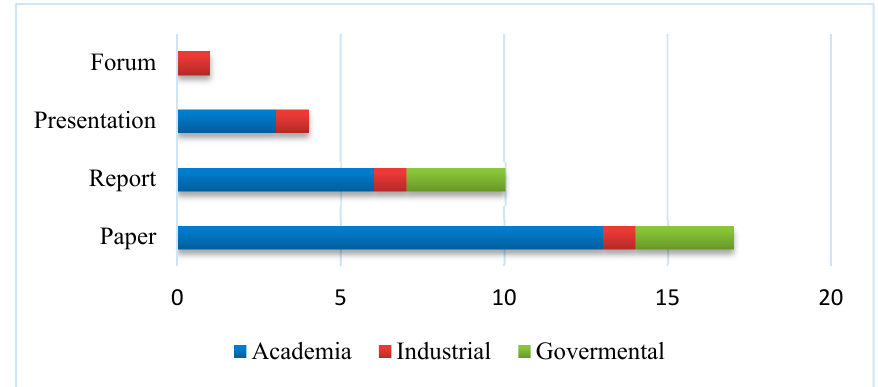
Figure 2. Literature overview: the number of the organization for SWS’s definition.